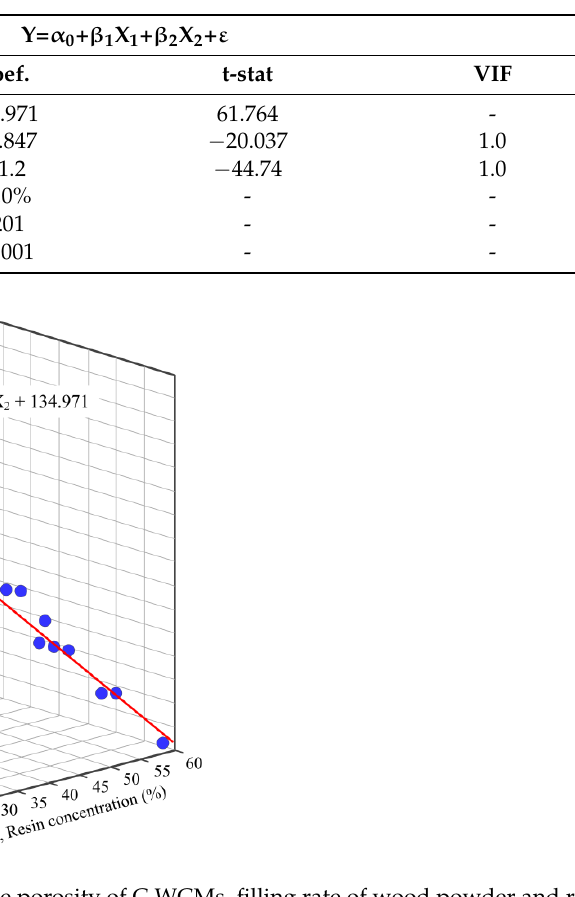
Table 3. Result of regression.